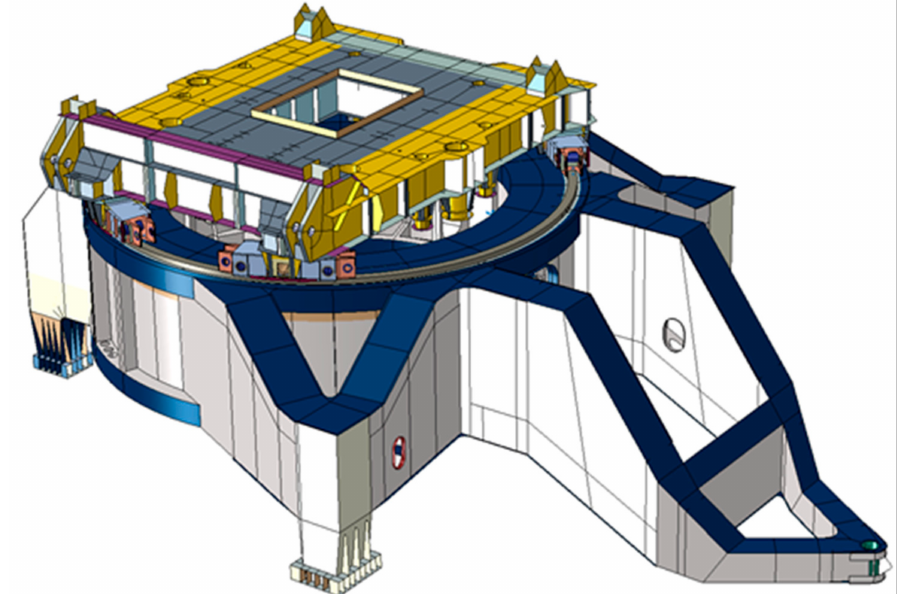
Figure 7. Example of a physical structure model: the portal frame of an excavator